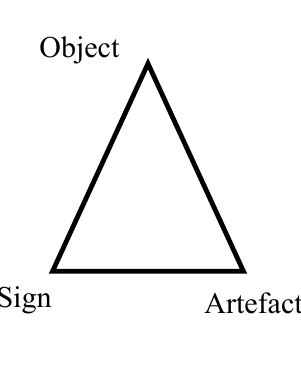
Figure 2. Semiotics and generic skills